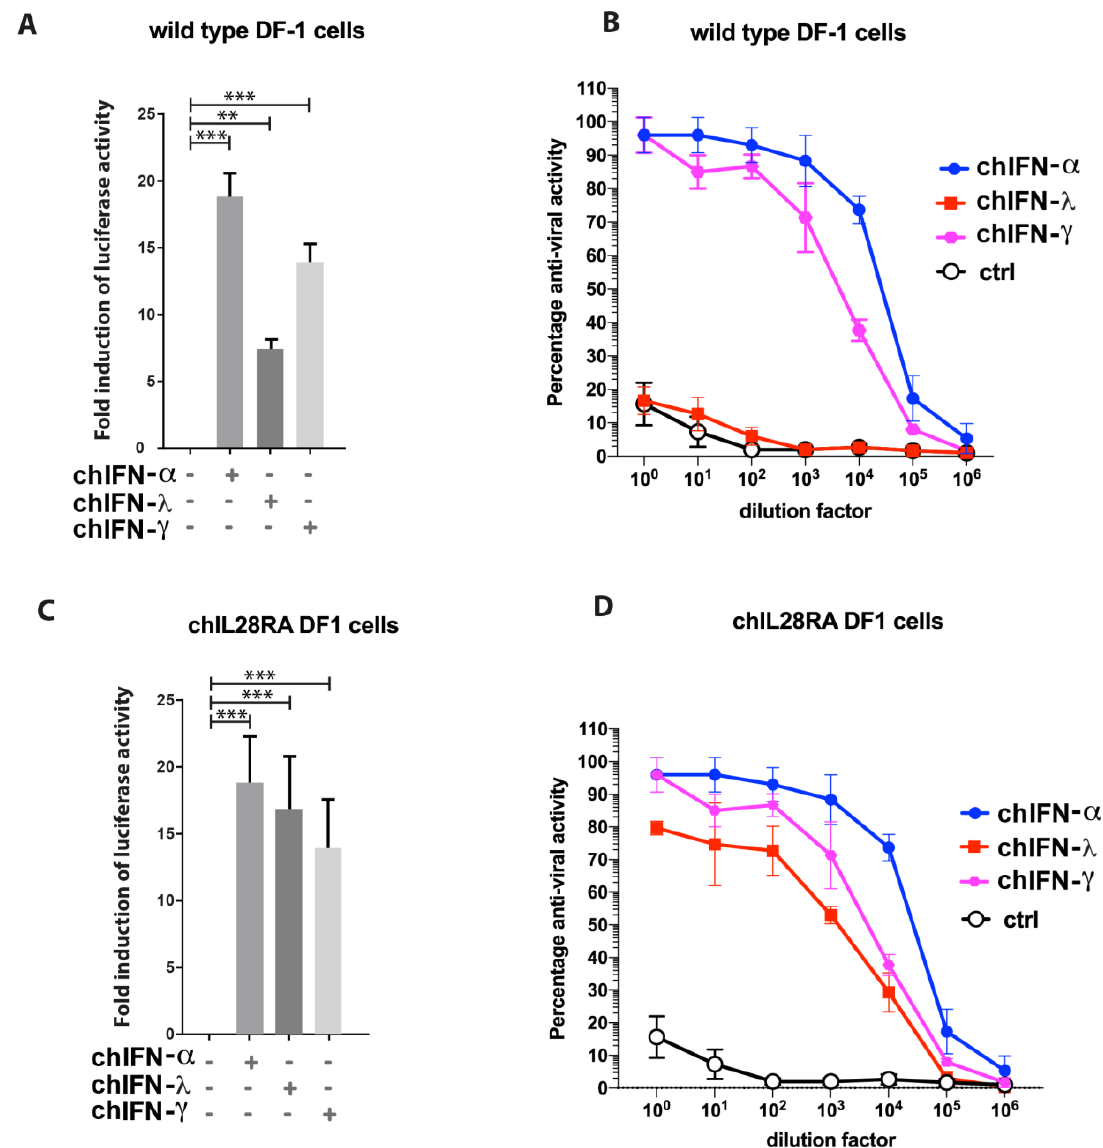
Figure 1. Responsiveness of chIL28RA DF-1 cells to chicken type I, II and III interferons (IFNs). Wild type ( A ) or chIL28RA DF-1 cells ( C ) were transfected with plasmid encoding luciferase genes downstream to chMx promoter and stimulated with chIFN- α , chIFN- γ or chIFN- λ for 24 h before lysis and measuring the luciferase activities. Fold induction was calculated compared to a mock-stimulated control. Wild type ( B ) or chIL28RA DF-1 cells ( D ) were treated with increasing concentration of chIFN- α , chIFN- γ or chIFN- λ for 24 hours followed by infection with the VSV-GFP for 24 h. The level of expression of GFP was measured and normalized to the mock-treated control. The data represent three independent experiments performed in triplicate. Error bars representing the standard deviation and asterisks show the level of significance (** p ≤ 0.01 and *** p ≤ 0.001).